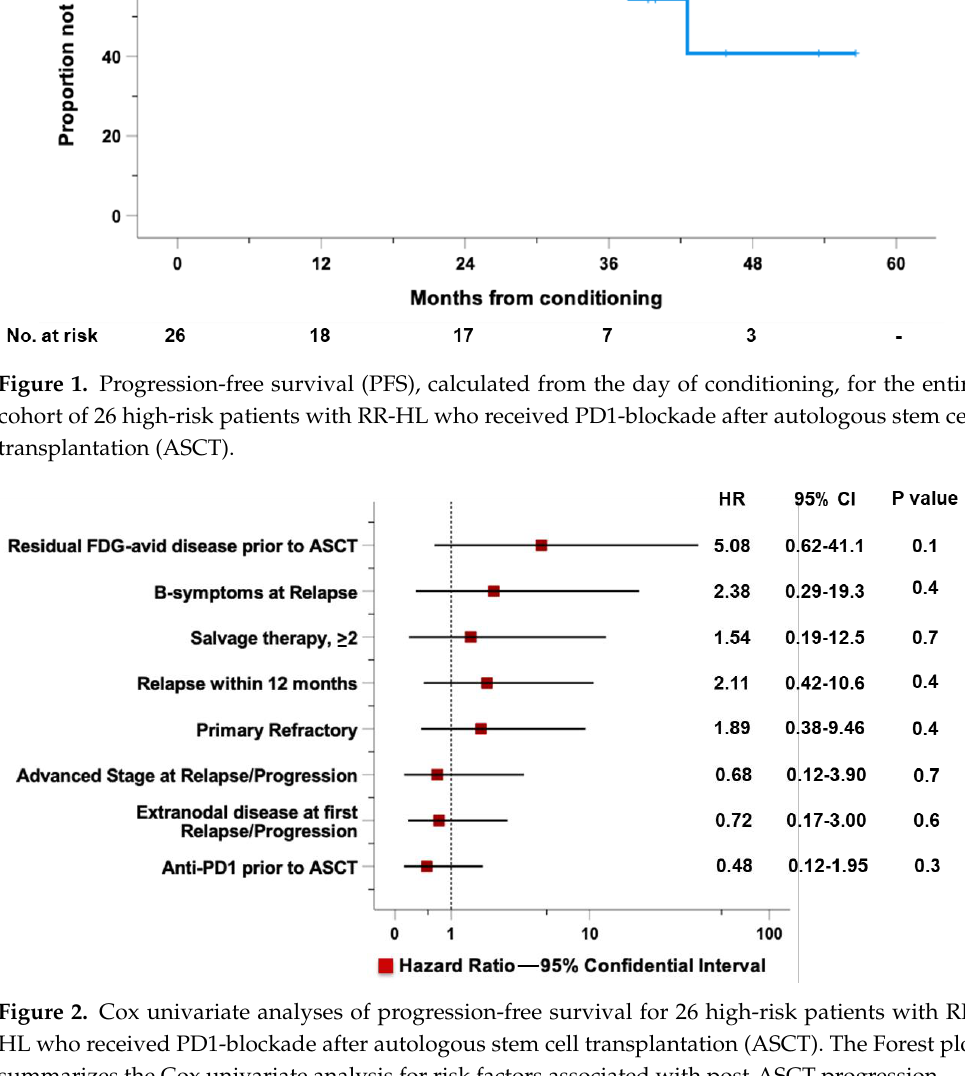
Figure 3. Progression - free survival (PFS), calculated from the day of conditioning, for the entire cohort of 26 high-risk patients with RR-HL who received consolidation with PD1-blockade after autologous stem cell transplantation (ASCT). Cases were clustered according to the achievement of